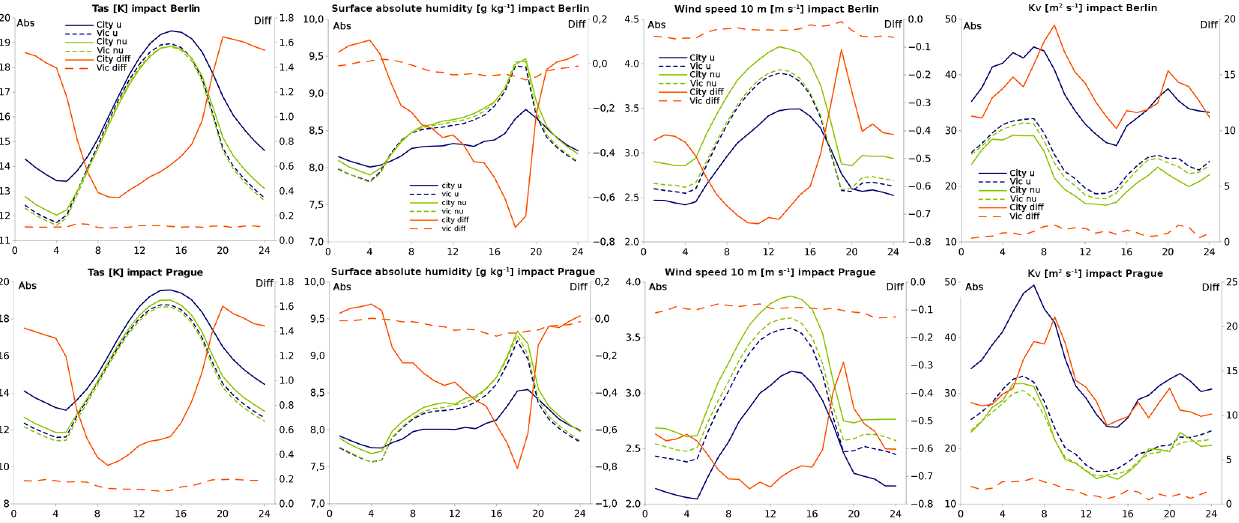
Figure 1. Diurnal cycle of the modeled near-surface temperature in ◦ C, absolute humidity in gkg − 1 , 10m wind speed in ms − 1 and the eddy diffusion coefficient in the fifth model level (about 700–800m) in m 2 s − 1 in local time for two selected cities, Berlin and Prague: blue – URBAN experiment, green – NOURBAN experiment, red – difference of URBAN and NOURBAN simulations, solid line – city averaged values, dashed line – city vicinity.